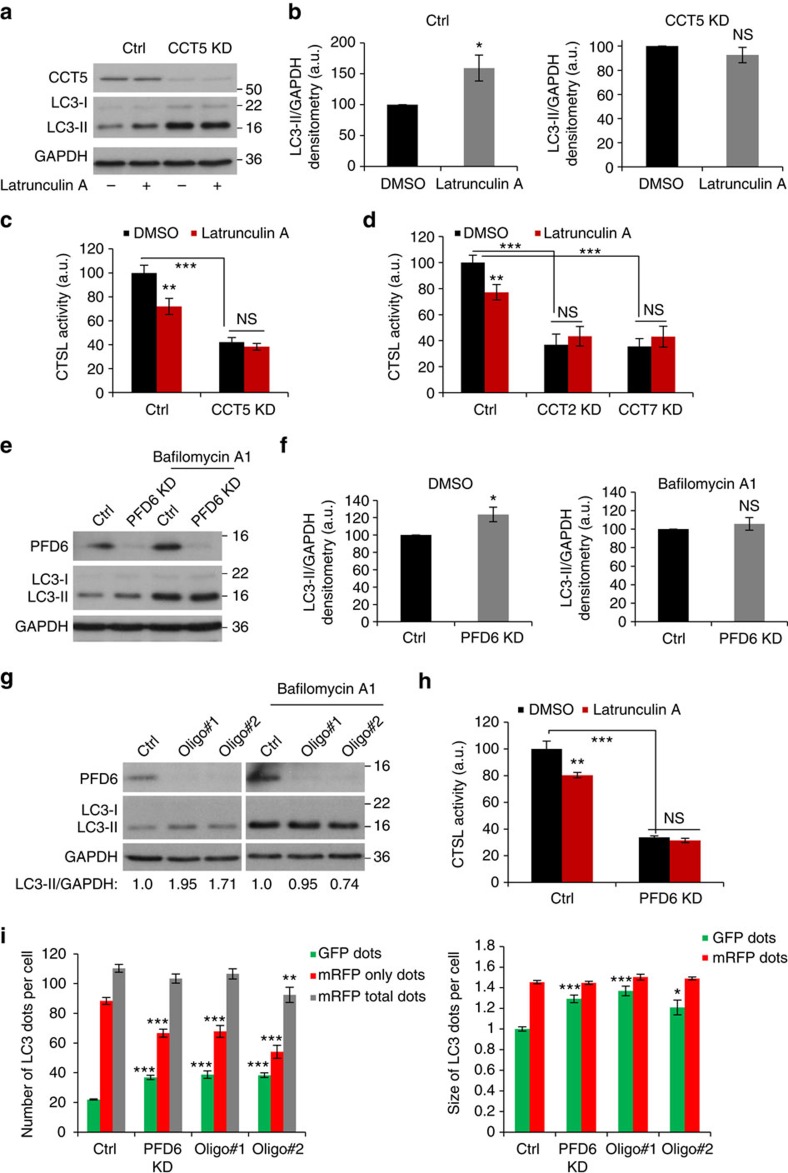
CCT controls lysosomes biogenesis via actin cytoskeleton.(a) LC3-II blots of HeLa cells treated with CCT5 siRNA and exposed to latrunculin A (1 μM, 3 h). (b) LC3-II/GAPDH densitometry in HeLa cells treated as in a. Bars—means±s.d. (n=3; *P<0.05, NS, not significant; two-tailed one sample t-test). (c) In vitro cathepsin L (CTSL) activity in HeLa cells exposed to CCT5 siRNA. Fluorescence intensity expressed as percentage of control. The cells were additionally exposed to Latrunculin A (3 h, 1 μM). Bars—means±s.d. (n=3; ***P<0.001, **P<0.01, NS, not significant; two-tailed t-test). (d) In vitro cathepsin L activity in HeLa cells exposed to CCT2 or CCT7 siRNAs. Fluorescence intensity was expressed as percentage of control. The cells were additionally exposed to Latrunculin A (3 h, 1 μM). Bars—means±s.d. (n=3; ***P<0.001, **P<0.01, NS, not significant; two-tailed t-test). (e) LC3-II levels in HeLa cells exposed to two rounds of PFD6 (prefoldin) smart-pool siRNA treatments in the presence/absence of Bafilomycin A1 (400 nM, 3 h). (f) LC3-II/GAPDH densitometry for HeLa cells exposed to two rounds of PFD6 (prefoldin) smart-pool siRNA and treated as in e. Bars—means±s.d. (n=3; *P<0.05, NS, not significant; two-tailed one sample t-test). (g) LC3-II blots of HeLa cells treated with individual PFD6 siRNA oligos in presence/absence of Bafilomycin A1 (400 nM, 5 h). LC3-II/GAPDH ratio is displayed relative to control. (h) Cathepsin L activity in HeLa cells treated as in e. Bafilomycin A1 was positive control (400 nM, 3 h). Bars—means±s.d. (n=3; ***P<0.001, **P<0.01, NS, not significant; two-tailed t-test). (i) Number and size of GFP dots (autophagosomes) and mRFP-only dots (autolysosomes). HeLa cells stably expressing mRFP-GFP-LC3 were treated with two rounds of siRNA (smart-pool PFD6 and two individual oligos), then seeded in a 96-well plate and subjected to Cellomics visualization analysis. Graphs show the results for one representative experiment: 10 wells of 100–200 cells each were analysed per sample. Similar data was seen in other two independent experiments. Bars—means±s.e.m. (n=10; ***P<0.001, **P<0.01, *P<0.05; two-tailed t-test).